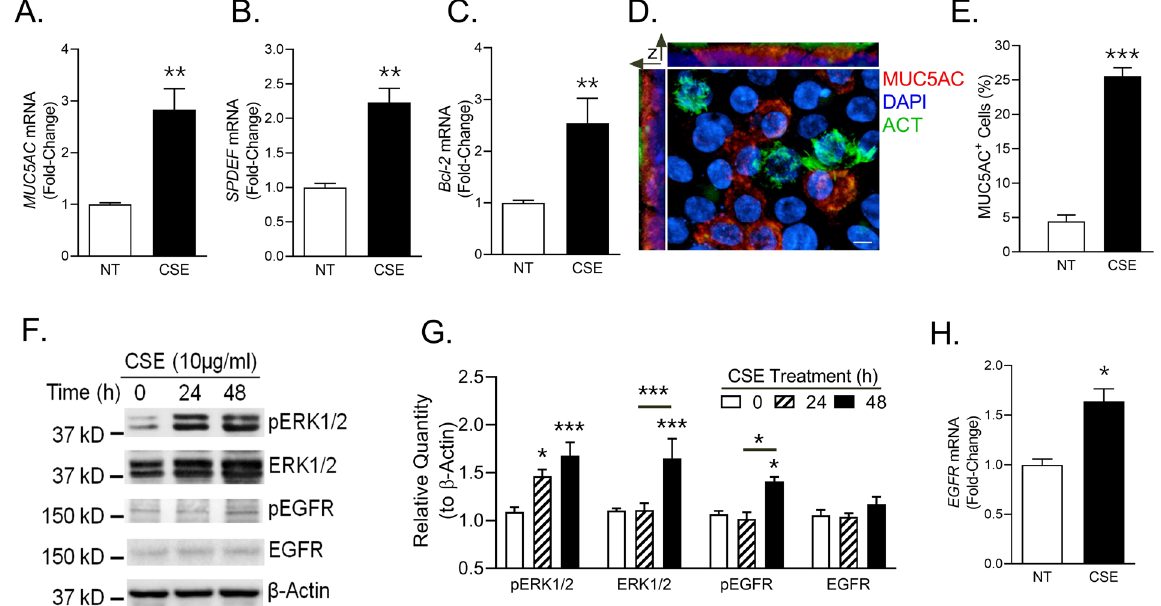
Figure 3. CSE engages EGFR and ERK1/2 pathways to induce mucous phenotype and Bcl-2 levels in differentiated human AECs. Primary human AECs differentiated for 3 weeks on air-liquid interface were treated with 10 µ g/ml of CSE for 48 h and the mRNA levels of MUC5AC ( A ), SPDEF ( B ) and Bcl-2 ( C ) were analyzed by qRT-PCR. ( D ) A 3-D representation of a micrograph showing cilia (green) and MUC5AC (red) immunopositivity in differentiated human AECs treated with CSE. Differentiated human AECs were treated with 10 µ g/ml CSE for 48 h and were immunostained for acetylated-tubulin (ACT, in green) for cilia and MUC5AC (red), and nuclei were stained with DAPI (Scale – 5 µ ). ( E ) Quantification of MUC5AC immunopositive cells following CSE exposure. Approximately 300 cells from each treatment were analyzed to calculate the percentage of MUC5AC-positive (MUC5AC + ) cells. ( F ) Immunoblot analyses of EGFR and ERK1/2 signaling pathway following CSE exposure. Differentiated human AECs were treated with 10 µ g/ml CSE and cell lysates were analyzed at 0, 24 and 48 h post CSE exposure by western blot analysis for phosphorylated ERK1/2, total ERK1/2, phosphorylated EGFR and total EGFR with β -actin levels as the loading controls. ( G ) Relative quantities of pERK1/2, ERK1/2, pEGFR and EGFR as determined by densitometric analysis where protein quantities were normalized to β -actin levels. ( H ) Fold-change in EGFR mRNA levels in human AECs treated with 10 µ g/ml of CSE for 48 h. Data shown as mean ± SEM (n = 3); * p < 0.05; ** p < 0.01; *** p <